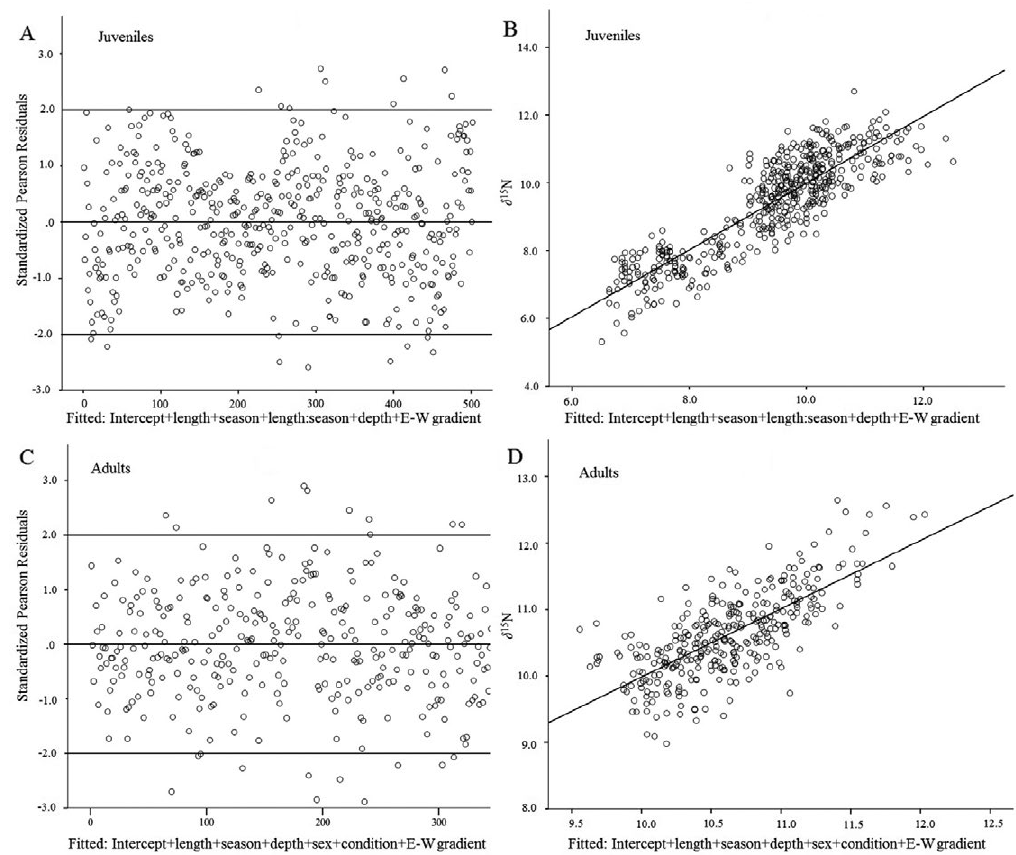
Fig. 7. – Results of the GLM with a Gamma error and an identity link for juvenile (A, B) and adult (C, D) hakes: plots of the residuals and the fitted values versus δ 15 N.